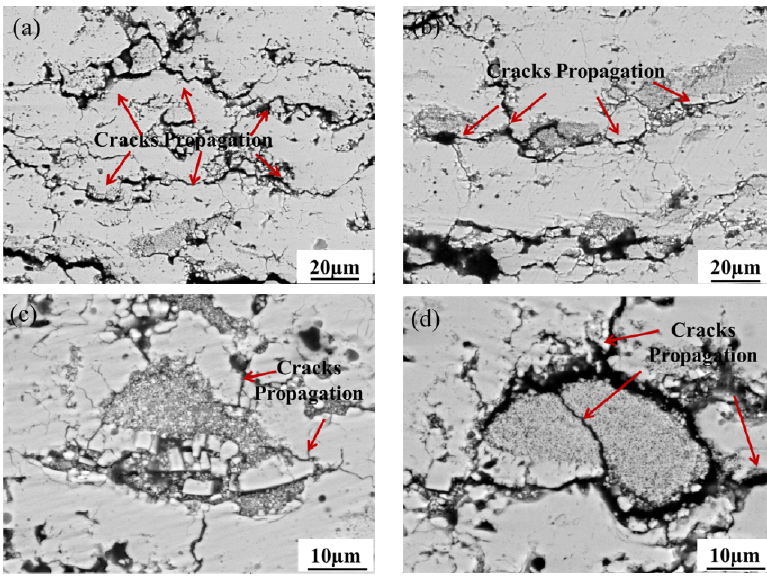
Figure 11. Effect of UNPs on cracks propagation behavior. ( a ) Horizontal propagation; ( b ) capture effect; ( c ) inhibition effect of cracks propagation by interface; ( d ) change of propagation direction.